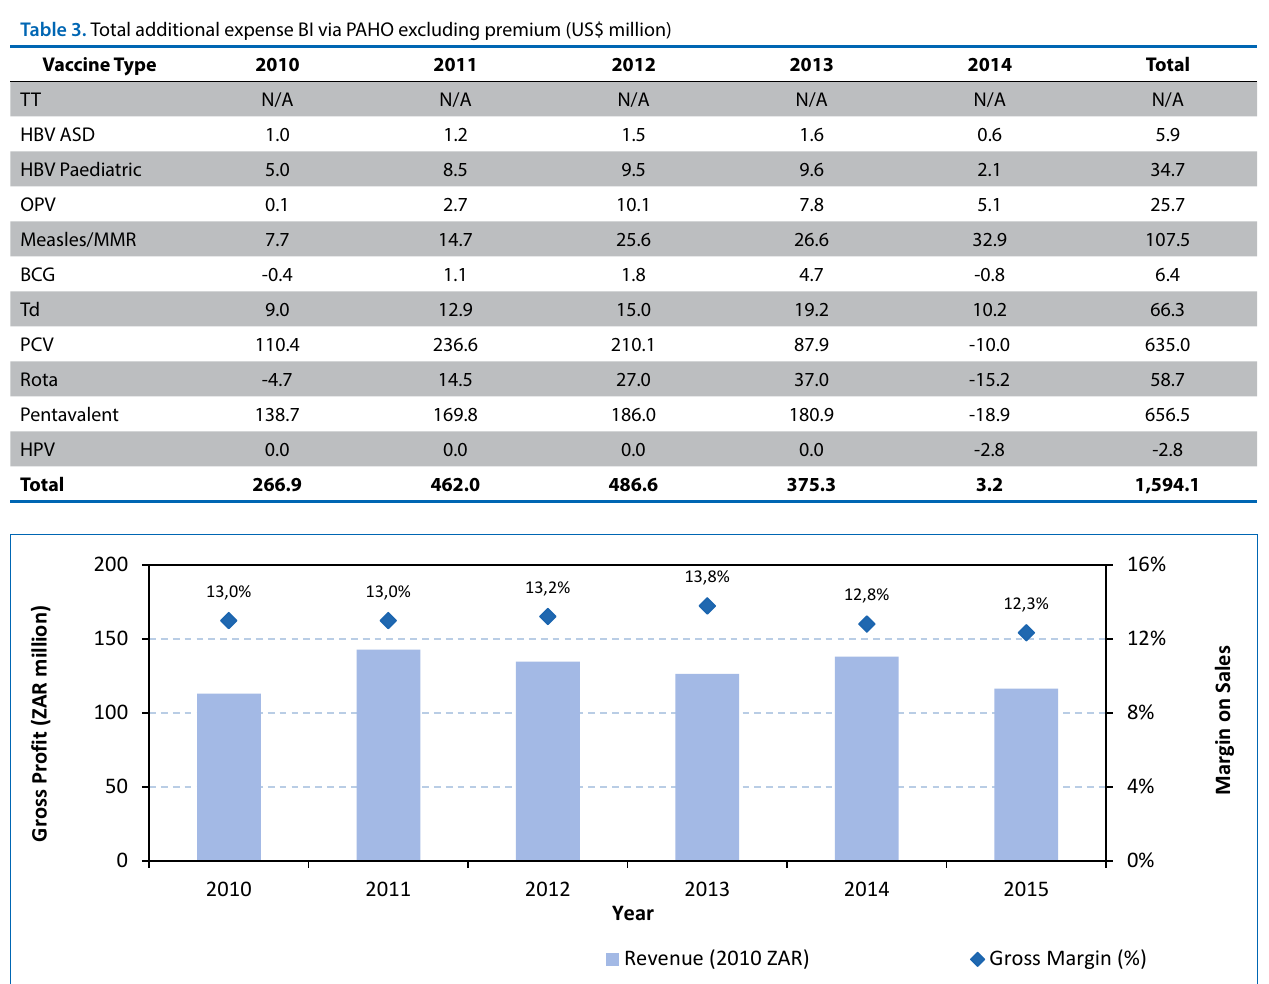
Figure 3. Gross profit and margin over the evaluation